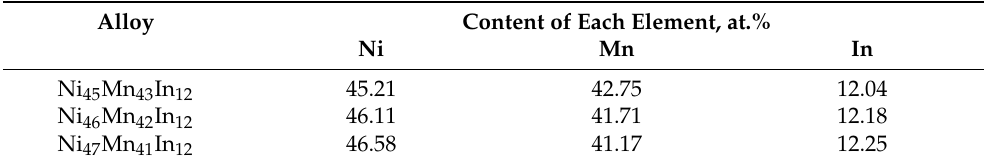
Table 2. Chemical analysis results of the Ni 47 − x Mn 41+x In 12 (x = 0; 1; 2) alloys. Alloy Content of Each Element, at.%